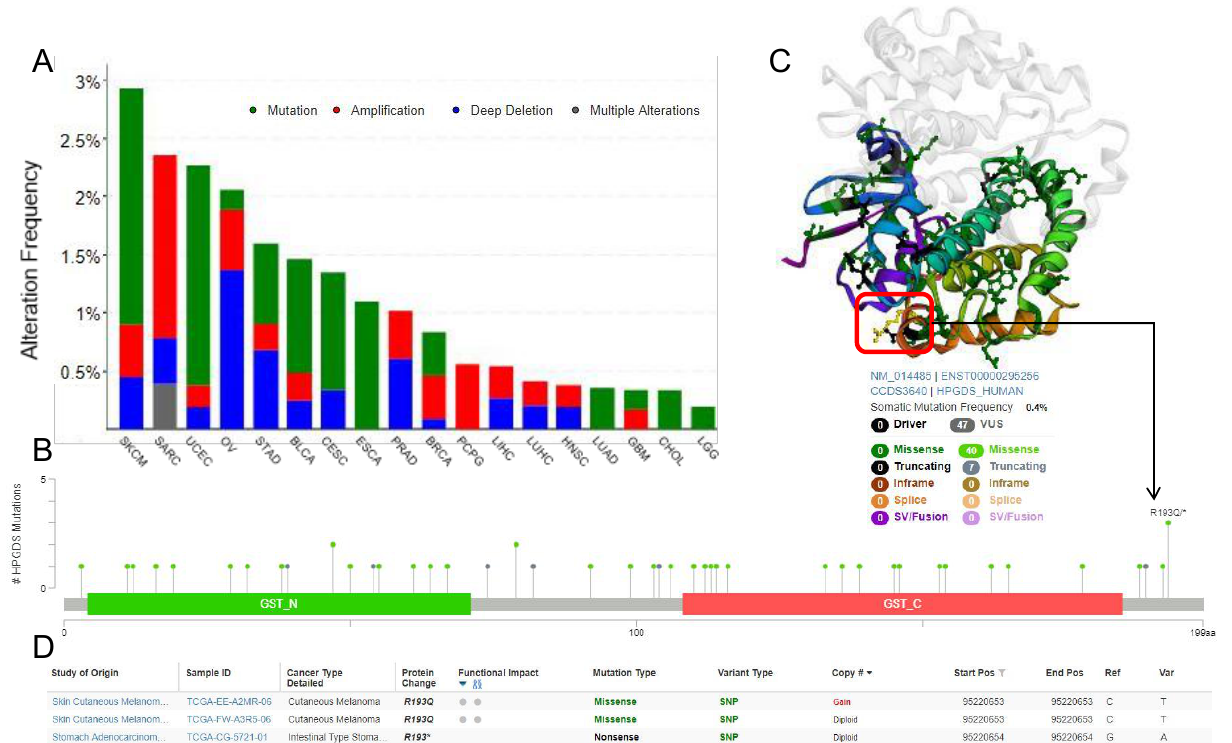
Figure 3. Analysis of the TCGA database for the mutation status of HPGDS in different cancers. Figure 3. GC chromatogram for analysis of phytosterol standards (black line), and free/combined phytosterols in rapeseed oil after separation by SPE: free phytosterols in rapeseed oil (red line) and ( A ) The SNP level of HPGDS in TCGA tumors. ( B ) The SNP level of each site of HPGDS in TCGA combined phytosterols (after saponification) in rapeseed oil (blue line). Peak 1, β -cholestanol; Peak 2, tumors. ( C , D ) Information regarding the mutation site with the highest SNP frequency (R193Q/ + ). brassicasterol; Peak 3, campesterol; Peak 4, β -sitosterol. The location of this site in the three-dimensional structure of HPGDS is shown in